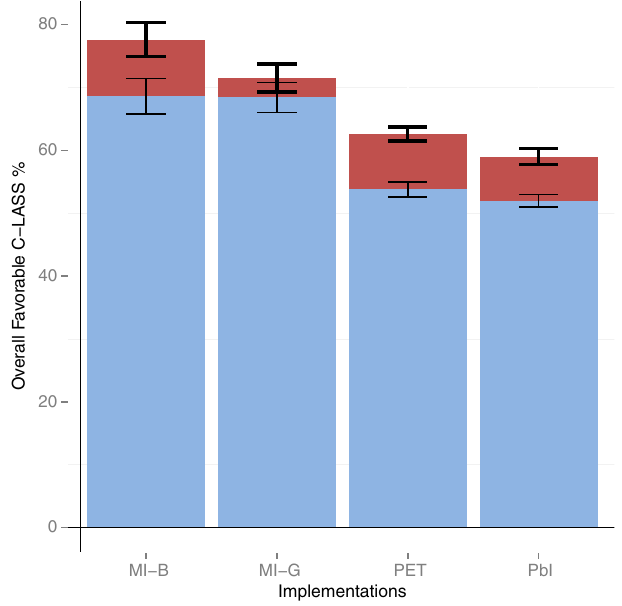
FIG. 1 (color online). Published positive shifts on the CLASS; see also Table I. Blue and red represent the pre- and postcourse percentages, respectively, of overall favorable responses. The error bars show standard error for pre and